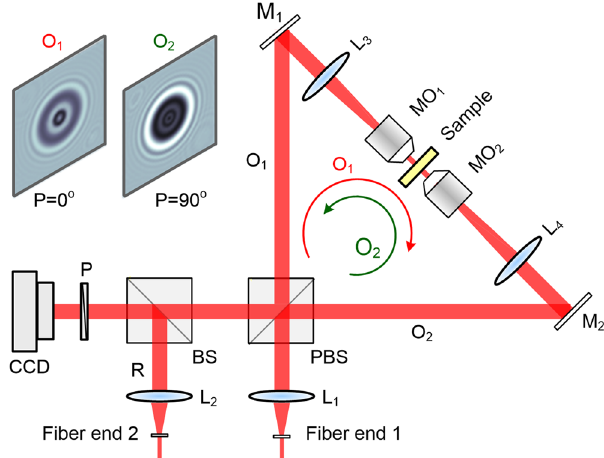
Figure 1. Experimental setup of opposite-view digital holographic microscopy (OV-DHM). MO 1 and MO 2 , microscopic objectives; L 1 –L 4 , achromatic lenses; BS, beamsplitter; PBS, polarization-maintaining beamsplitter; M 1 and M 2 , mirrors; P, polarizer; CCD, Charge-coupled device; O 1 and O 2 , Object waves linearly polarized along horizontal (0°) and vertical (90°) directions, respectively; R, reference wave linearly polarized at an azimuth of